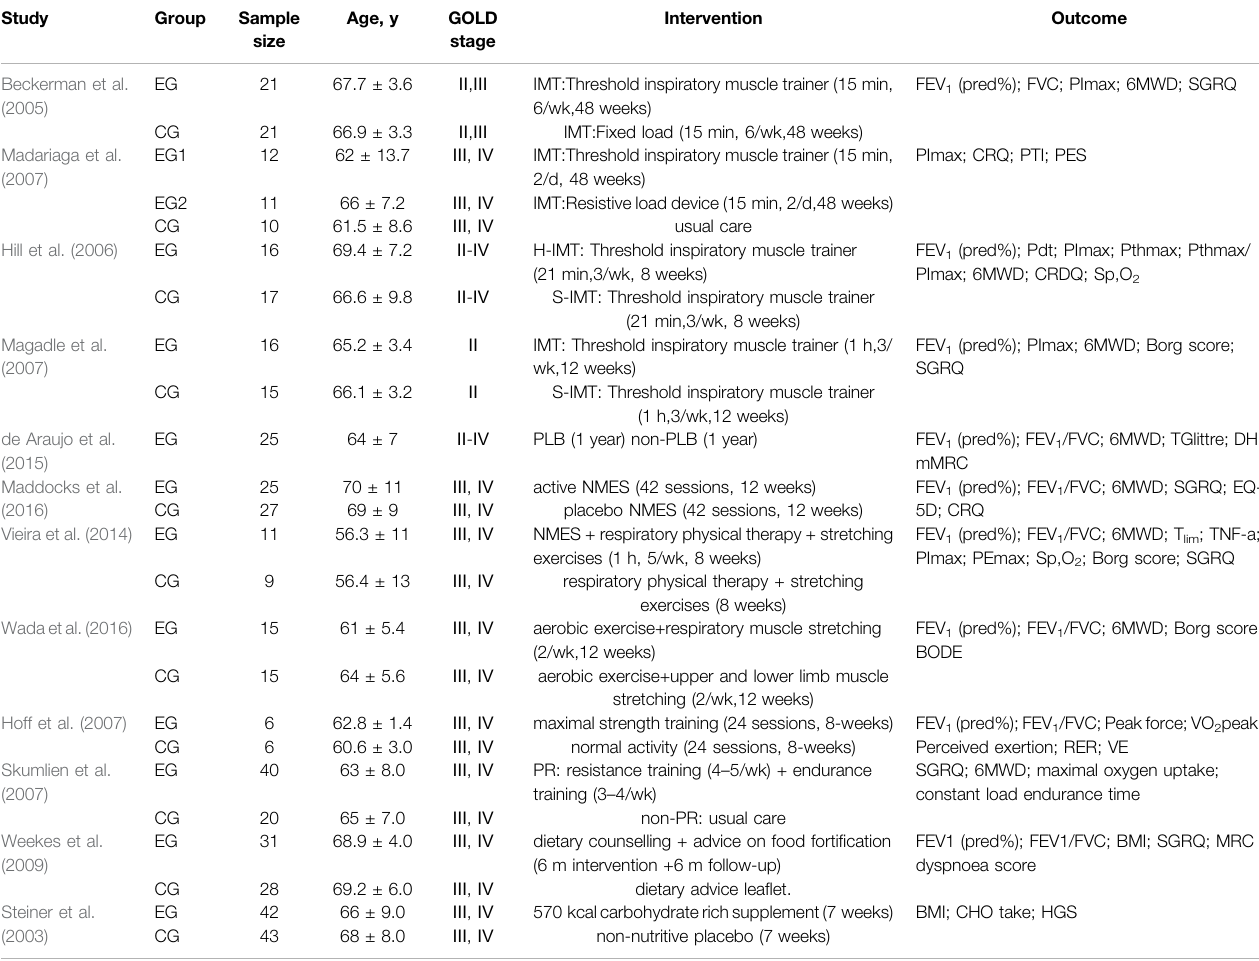
TABLE 1 | Characteristics of included studies. Study